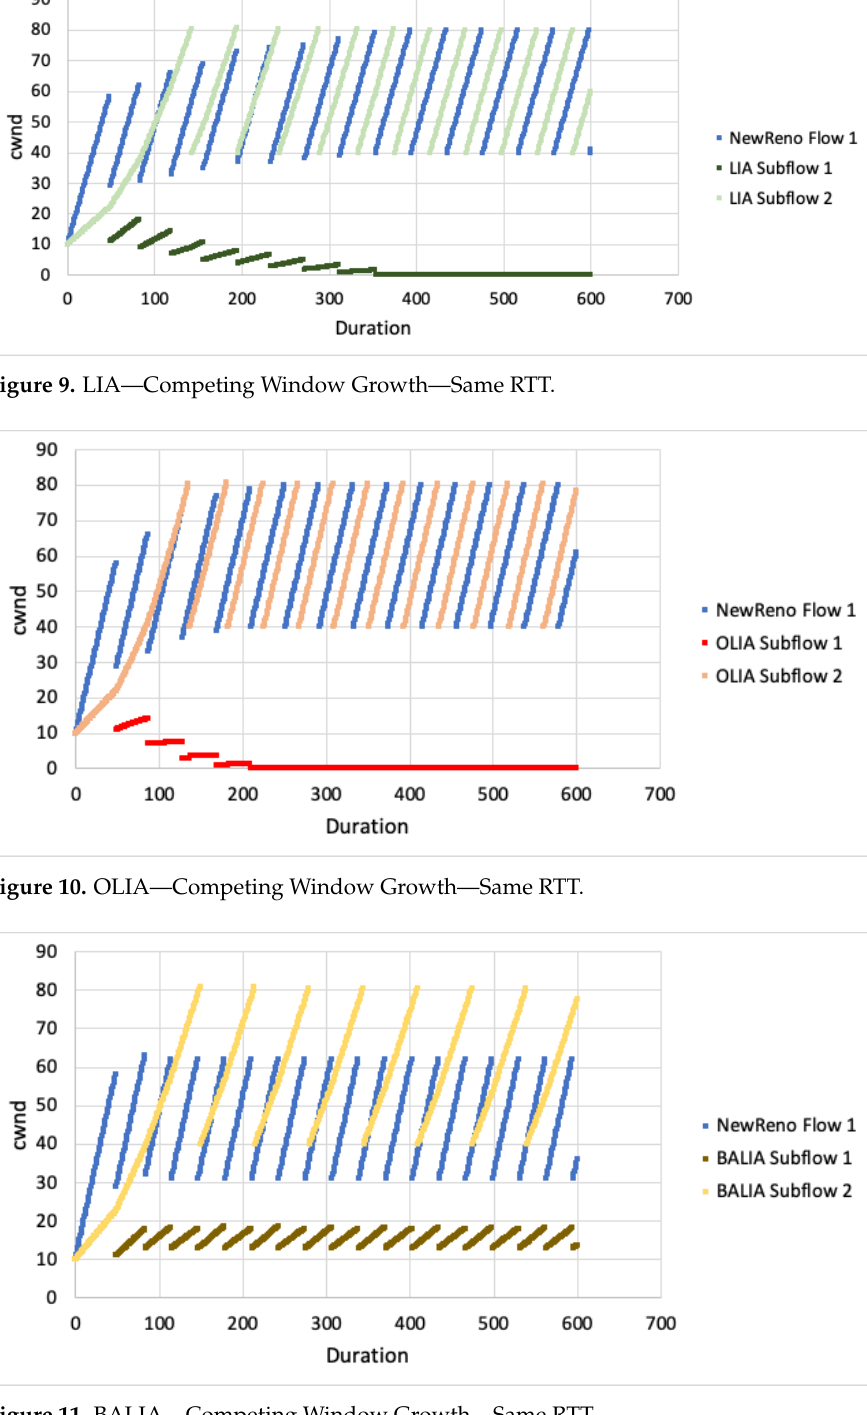
Figure 11. BALIA—Competing Window Growth—Same